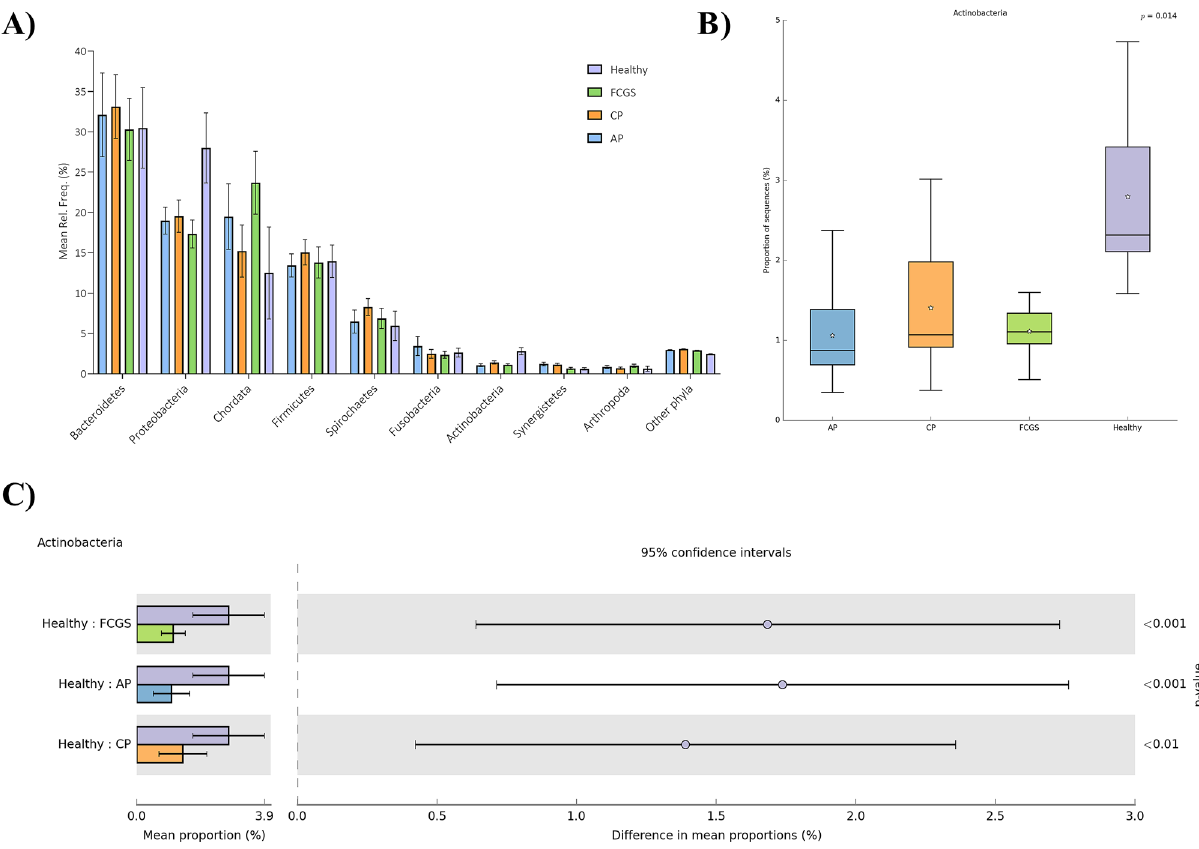
Figure 2. Distribution of phylum in subgingival metagenomes from healthy cats and cats diagnosed with aggressive periodontitis (AP), chronic periodontitis (CP) and feline gingivostomatitis (FCGS). ( A ) Bar graph representing the relative distribution (mean relative frequency (%) and standard error of the mean) of the most abundant phyla, minimum of 1% of abundance, in subgingival samples from cats. ( B ) Box and whiskers plots illustrating the mean (star), median (line within the box), quartiles (IQR; 75th to 25th of the data), maximum and minimum (whiskers extend to the most extreme value) proportion of sequences (%) of the phylum found with significant statistical difference in the metagenomic datasets studied (false discovery rate, FDR P -value < 0.05). The results were filtered using a P -value of 0.05 in STAMP v2.1.3 (Statistical Analysis of Metagenomic Profiles) software. ( C ) Extended error bar plots representing abundance of Actinobacteria that showed significant higher abundance in healthy cats compared to diseased cats using Tukey–Kramer with Benjamin-Hochberg FDR correction ( P -value < 0.05). ( A ) Generated using GraphPad Prism 9 (GraphPad Software LLC, La Jolla, CA, https:// www. graph pad. com). ( B , C ) Generated using STAMP v2.1.3 (Statistical Analysis of Metagenomic Profiles) software (https:// beiko lab. cs. dal. ca/ softw are/